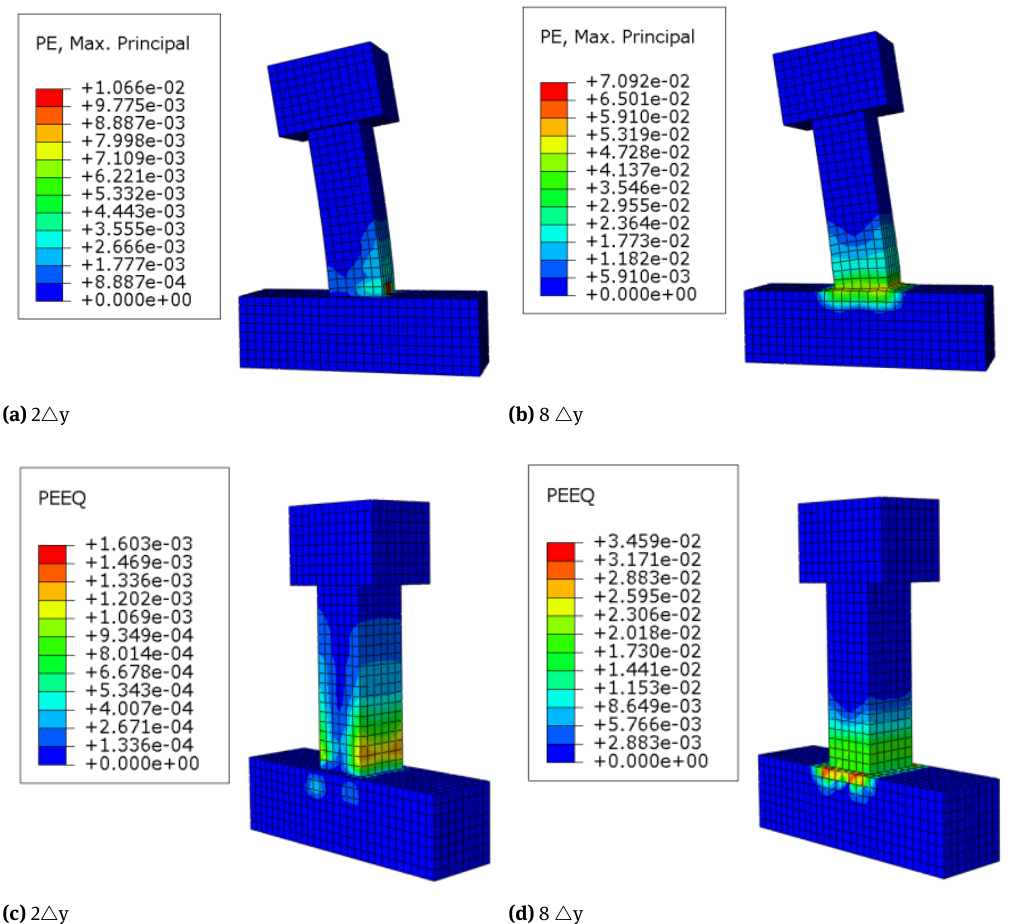
Figure 10: Nephograms of Equivalent Plastic Strain and Maximum Principal Plastic Strain of C3